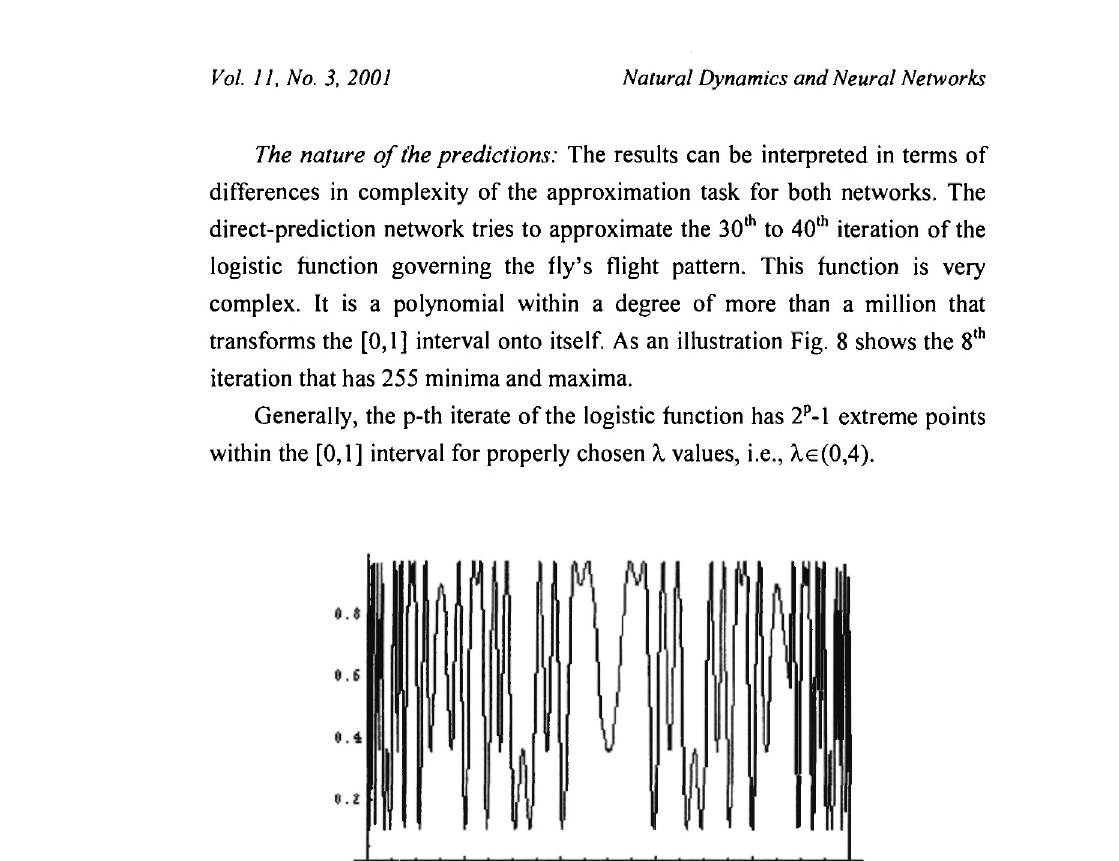
Fig. 8: The graph of the 8 th iteration of the logistic function.